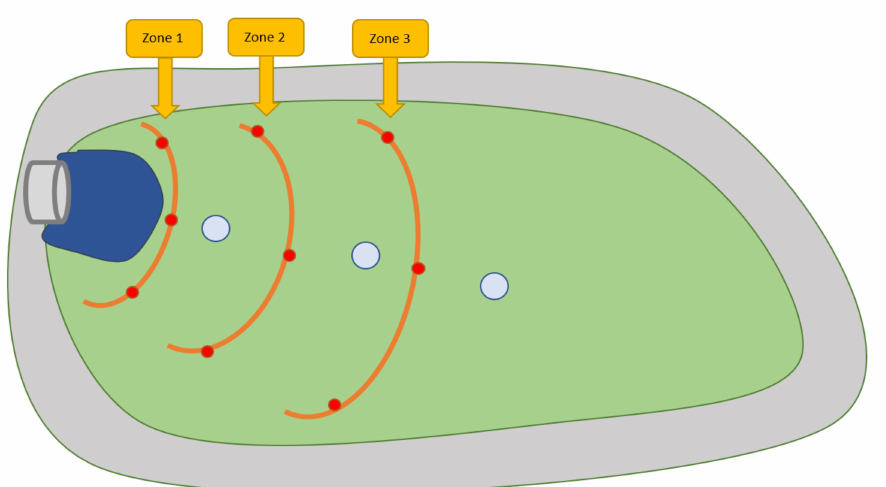
Figure 2. Diagram showing soil sampling point (red dots) and water sampling well (gray circles) distribution in zones of SIB sites. Zone 1 is the frequently flooded zone with hypothesized higher sediment accumulation than the other zones. Zone 2 is occasionally flooded and Zone 3 is rarely